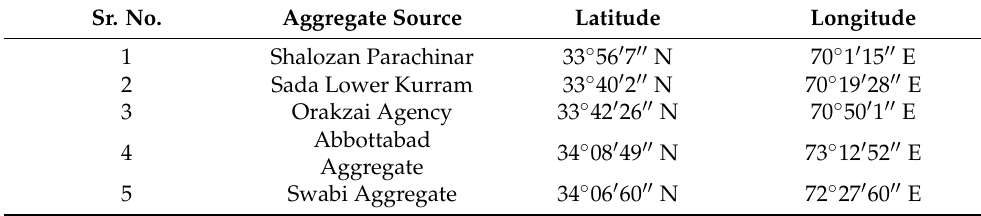
Table 2. Location of aggregate sources.